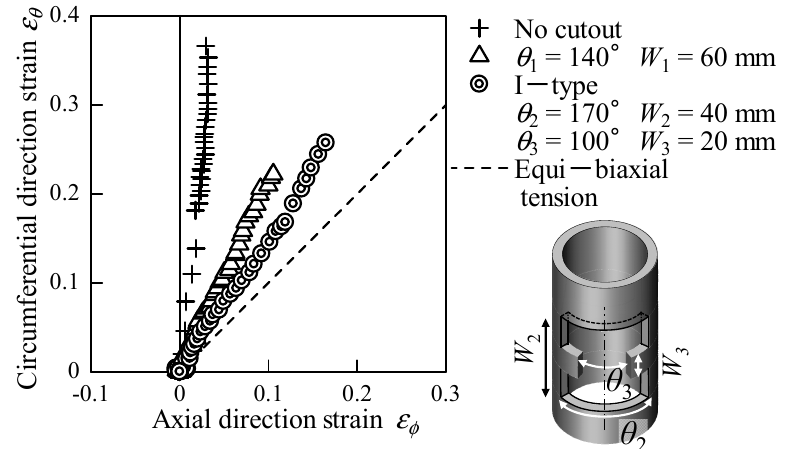
Figure 14. Strain paths of specimen with an I-type cutout.